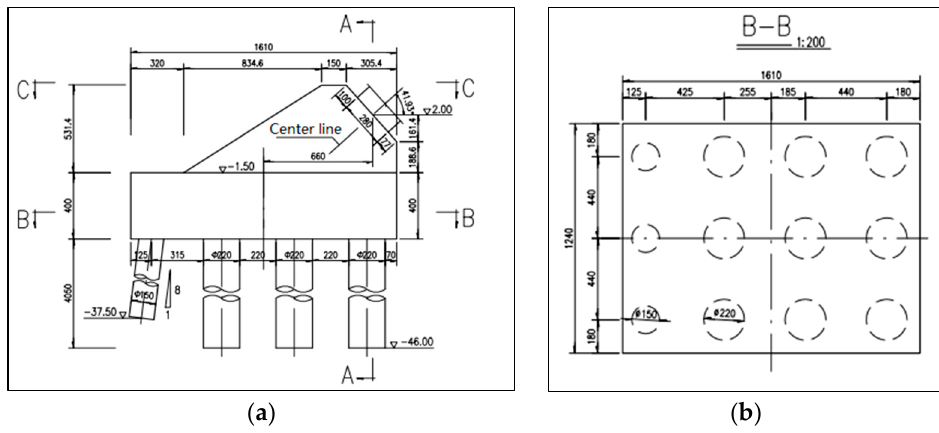
Figure 3. Structure diagram of arch seat: ( a ) elevation plan; ( b ) plan of piles cap foundation.